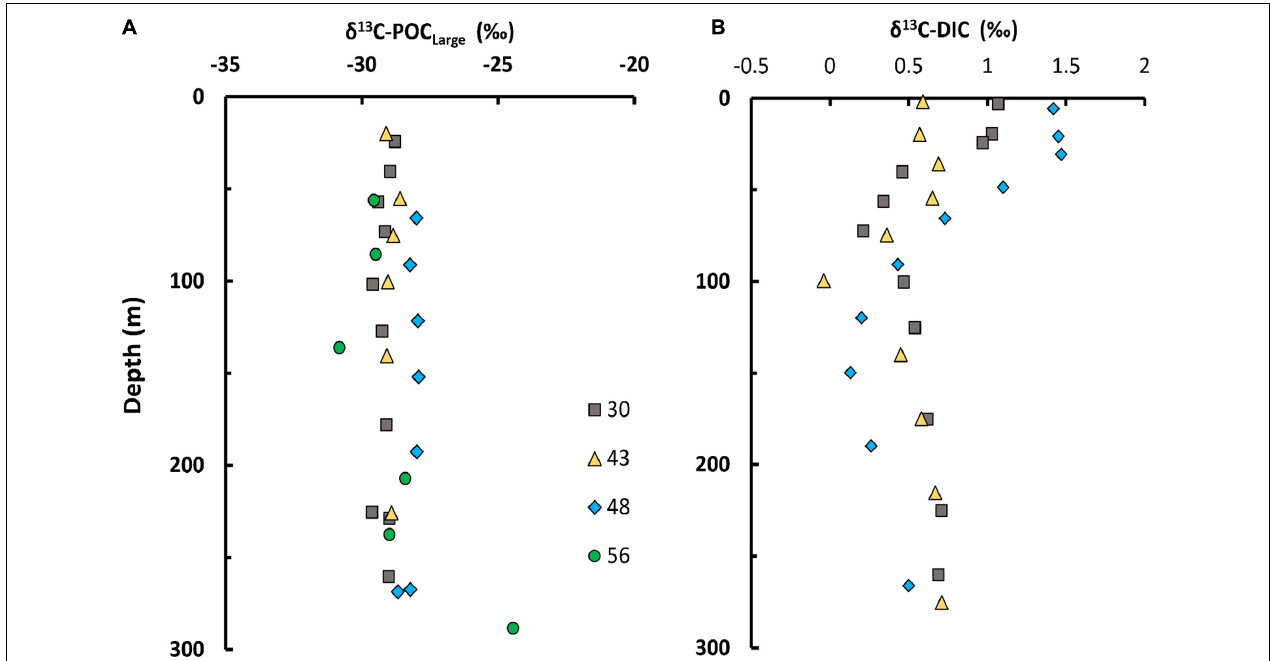
FIGURE 9 | (A) δ 13 C POC and (B) δ 13 C DIC distribution in the water column and large ( > 51um) particles.